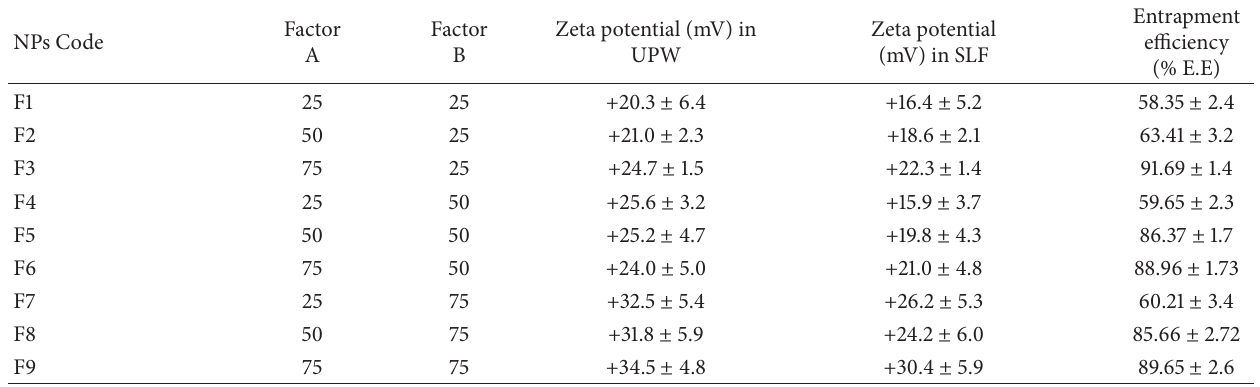
Table 5: Zeta potential and percent entrapment efficiency of different PLGA loaded NPs.